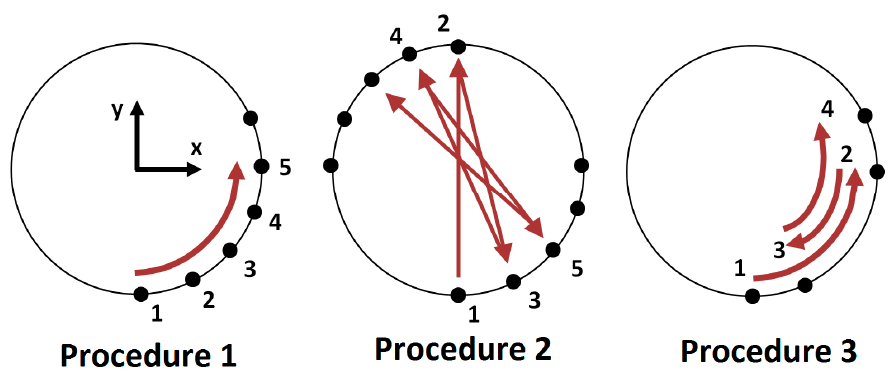
Figure 3. Procedures used during probe hysteresis error determination. Procedure 1 was treated as a reference. In all cases the coordinate system was set as in Procedure 1.